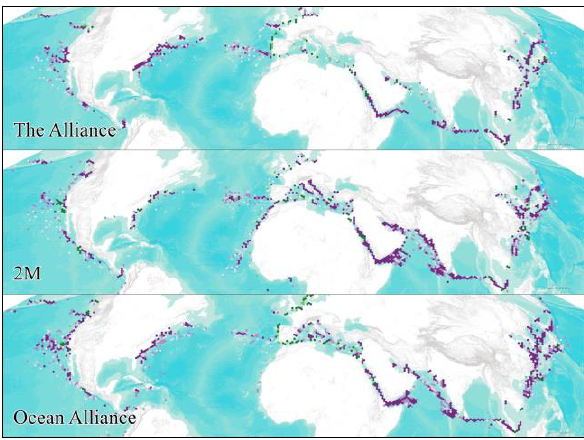
Figure 15 Trend analysis counted AIS’ positions over all bin locations, for three of the major naval alliance: The Alliance, 2M and the Ocean Alliance transiting at a global